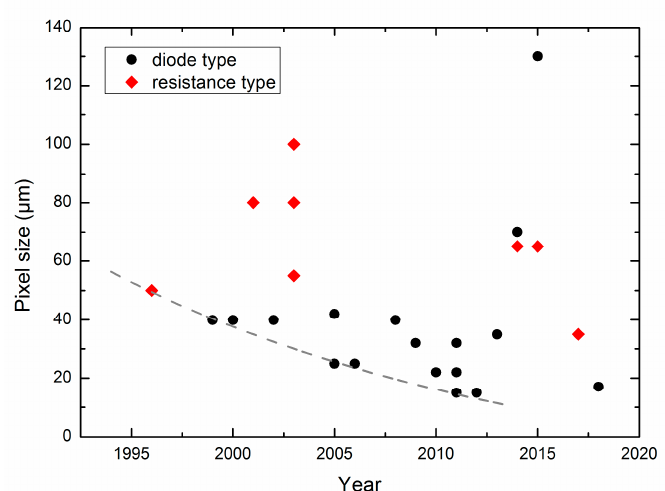
Figure 1. Trends of the pixel size reduction for complementary metal oxide semiconductor (CMOS)-compatible microbolometer infrared (IR) detectors, data taken from (in left-to-right order) [12–15,17–22,25,27–29,31–35,37,39–41,43,46].